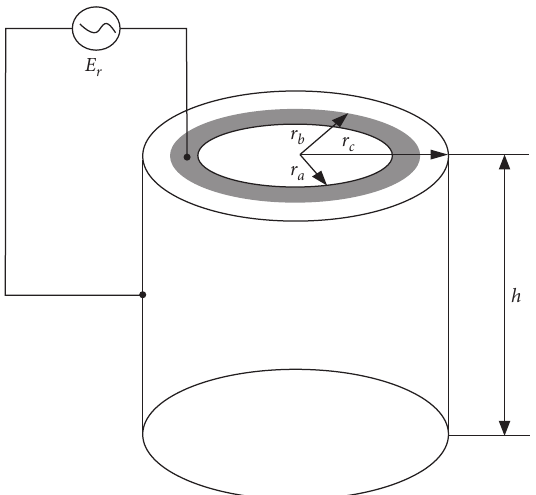
Figure 1: Schematic diagram of the transducer.